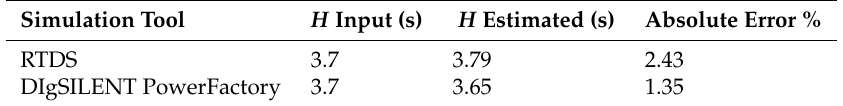
Table 3. Inertia estimation results at bus 1, Case 3 phase short-circuit and PI